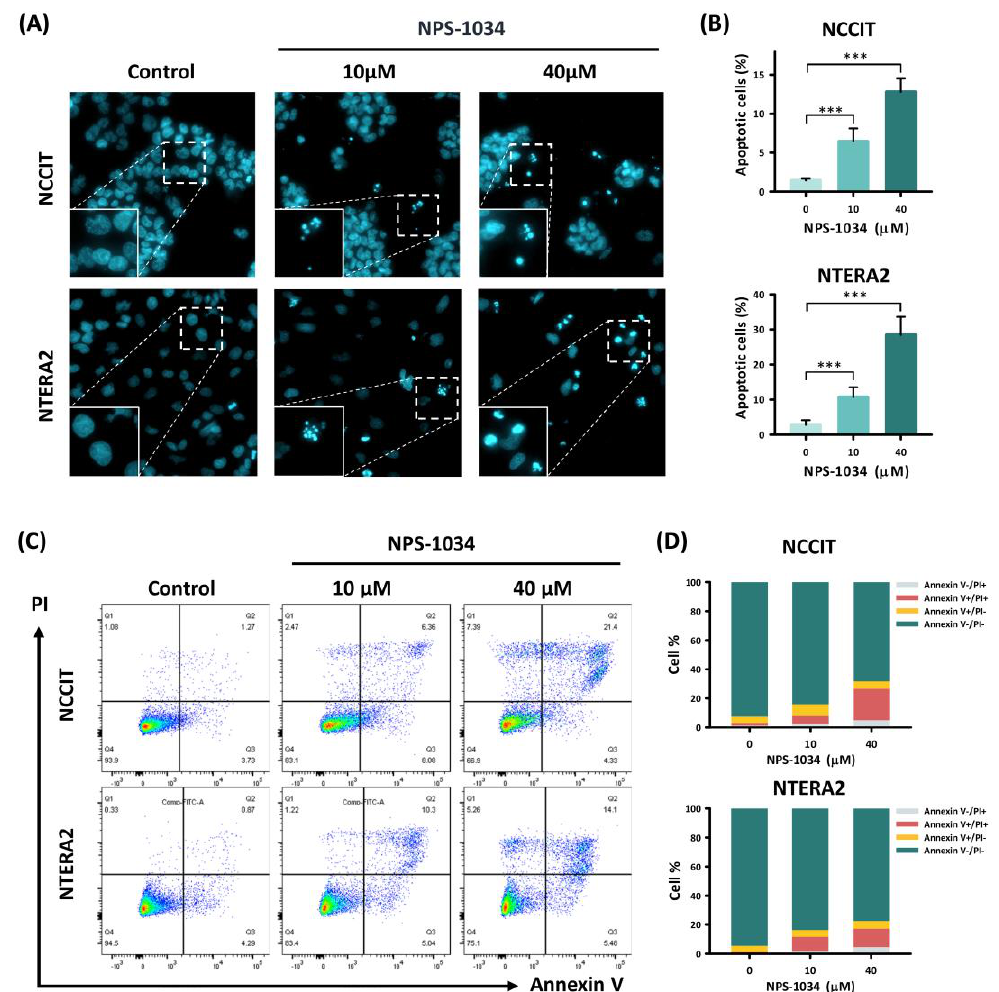
Figure 2. NPS-1034 promotes apoptosis in TC cell lines. ( A ) Hoechst stain 33,342 was used to visualize the apoptotic cells of the NCCIT and NTERA2 cell lines treated with NPS-1034 (0, 10, and 40 µ M) for 24 h. ( B ) The percentage of apoptotic cells is presented in the columns. ( C ) Flow cytometry was conducted to evaluate the cause of cell deaths with annexin v/PI dual stain. An examination was performed to determine the number of apoptotic NCCIT and NTERA2 cells treated with NPS-1034 for 48 h. ( D ) The proportion of cell distribution is shown in the column for NCCIT and NTERA2 cells. The data are presented as mean ± SD (*** p <